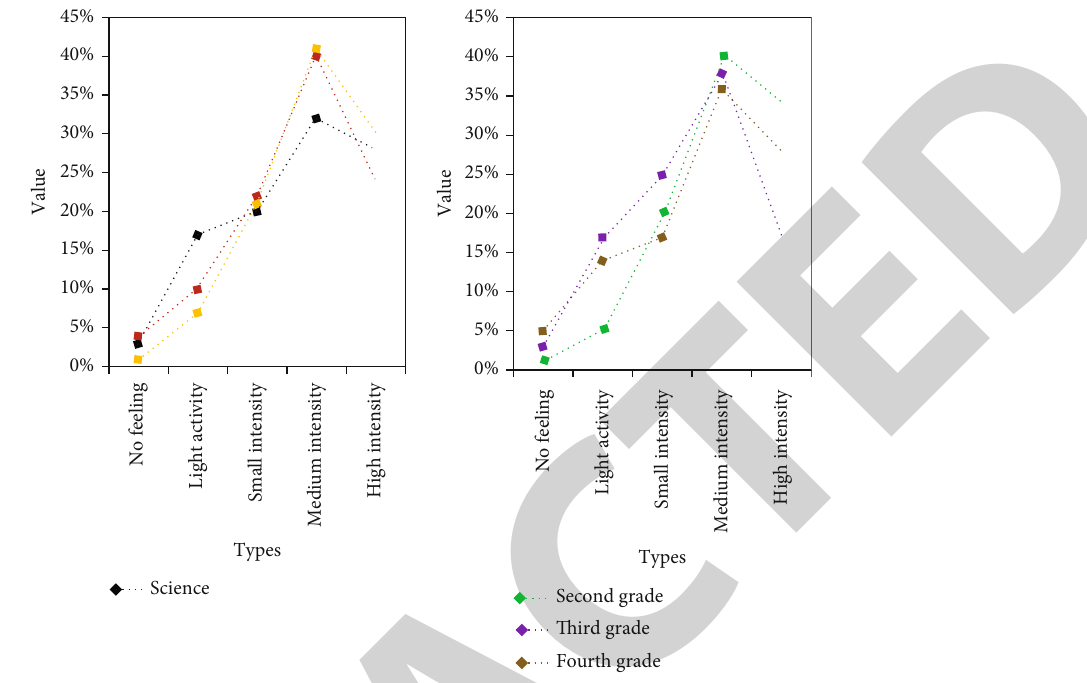
Figure 8: Physical exercise intensity of college students in di ff erent disciplines and di ff erent grades.